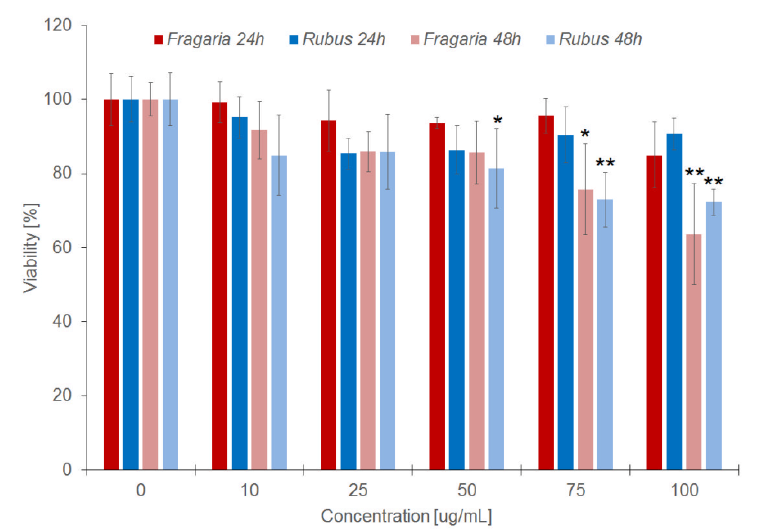
Figure 2. The percent of viability in cells modified by Fragaria and Rubus extracts after 24 h (grey bars) and 48 h (black bars) of incubation, calculated on the basis of the Hoechst 33342 assay results. Statistically significant differences between modified and control cells are marked: * α = 0.05; ** α = 0.01 .